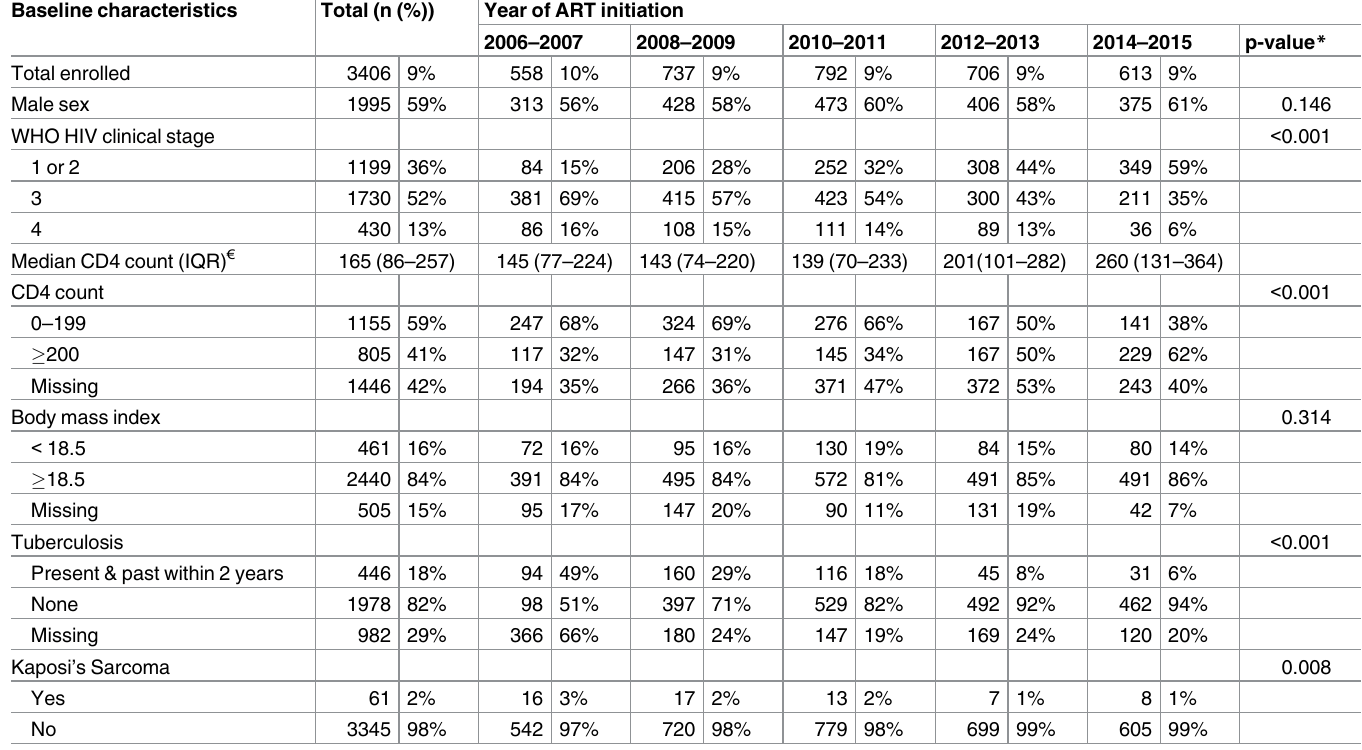
Table 2. Baseline characteristics of adult patients (aged (cid:21) 50) starting ART, by year of ART initiation. Baseline